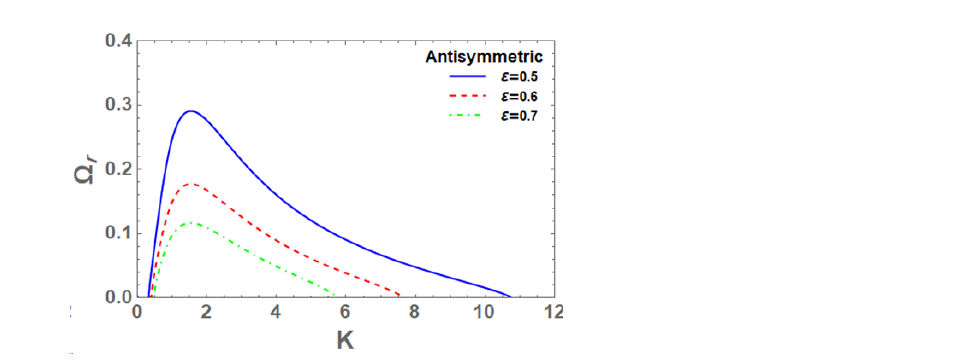
Figure 8. Non-dimensional growth rate Ω r and non-dimensional wave number K for different values of porous medium porosity ε , when We = 1000; Oh = 0.1; N = 1; v = 0.2; κ 1 = 2; ˜ (cid:101) l = 0.3; ˜ (cid:101) g = 0.1; E = 3; U = 1.5; V (cid:48) = 0.1; ε = 0.5, for axisymmetric disturbance case.